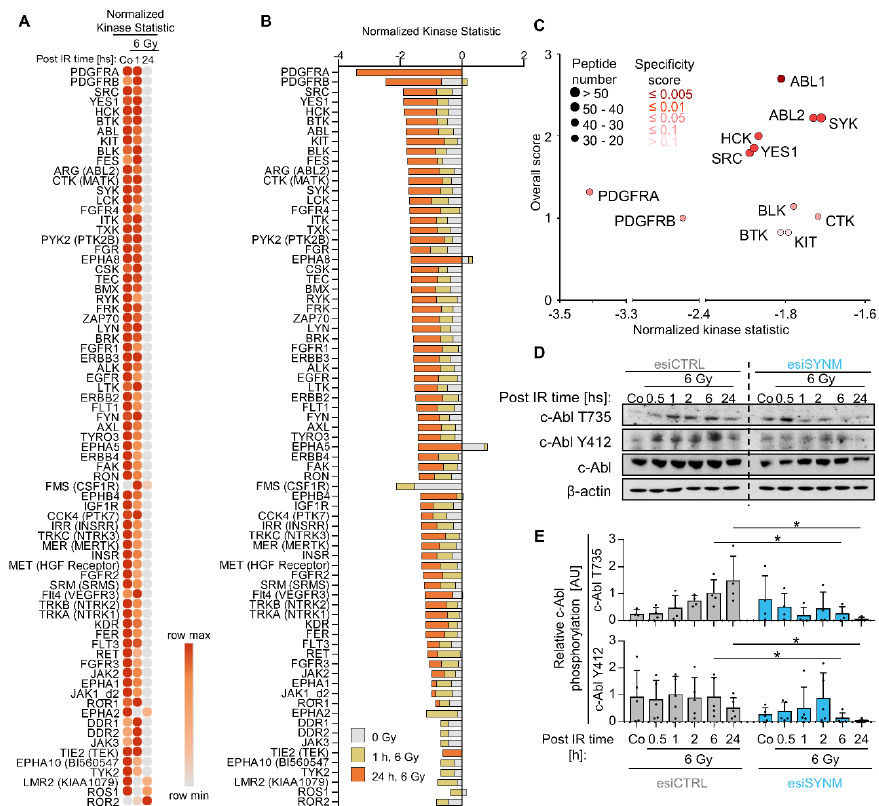
Figure 3. Synemin regulates c-Abl kinase activity. ( A ) Heatmap of tyrosine kinase activities in cells depleted of synemin and exposed to 6 Gy X-ray. Kinase activity profiles were generated by PamGene Technology. ( B ) Normalized kinase statistic of un-irradiated controls (grey) and samples 1 h (yellow) or 24 h (orange) post 6 Gy X-ray exposure. ( C ) Top affected tyrosine kinases in synemin-depleted cell cultures 24 h post 6 Gy X-ray irradiation. X -axis indicates the τ value for each kinase ( τ < 0 indicates reduced kinase activity relative to control). Dot colors indicate the specificity score. Dot size indicates the number of included peptides. The Y -axis shows the overall score. ( D ) Western blotting of c-Abl expression and phosphorylation from whole cell lysates of synemin-depleted cells. ( E ) Densitometries of Western blots from synemin-depleted, 6-Gy irradiated cells showing phosphorylated forms of c- Abl shown in “D” (Y412 and T735, n = 4). Phosphorylation levels were calculated relative to the total amount of c-Abl. Dots represent each independent experiment. Data are presented as mean ± SD (two- sided t -test; * p < 0.05).